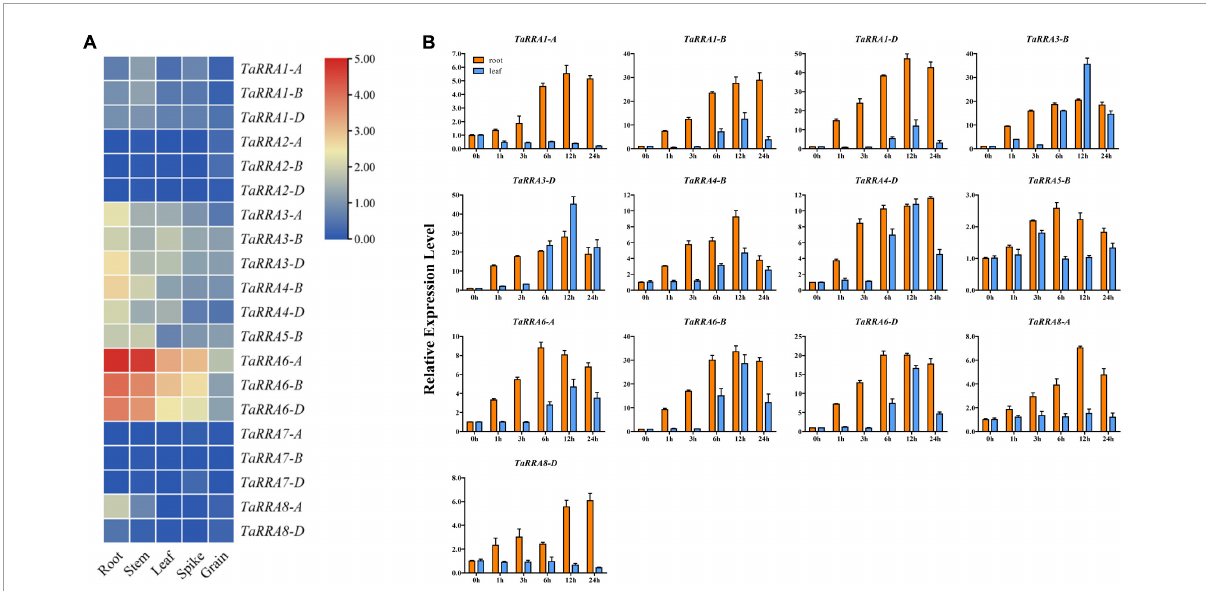
FIGURE6 Expression analysis of TaRRA genes. (A) Expression profiles of TaRRA genes in various tissues. The RNA-sequence data was obtained from leaf, root, stem, spike, and grain of Chinese Spring (International Wheat Genome Sequencing Consortium [IWGSC], 2014). (B) Quantitative RT-PCR analysis of TaRRA genes in response to cytokinin treatment. Leaves and roots of 10-day-old seedlings were sampled after 50 µ M 6-BA treatment for 0, 1, 3, 6, 12, and 24 h. The data are given as means ± SE of three biological